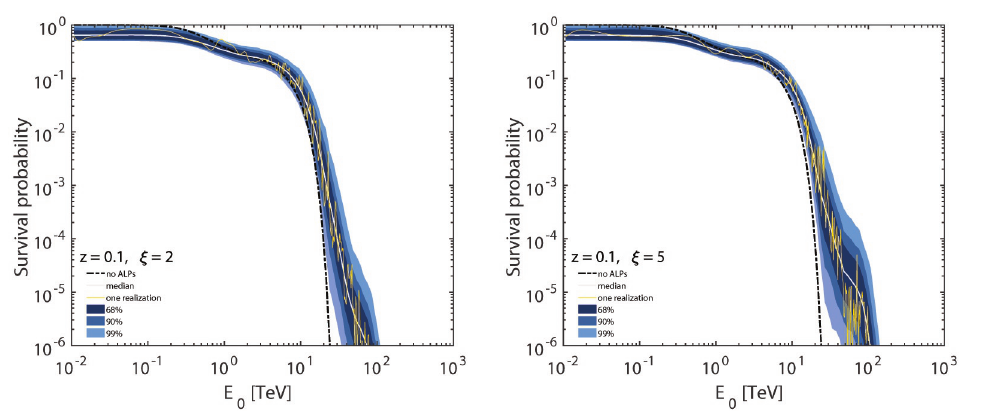
Figure 19. Same as Figure 17 apart from z = 0.1. (Credit [115]). Figures for z = 0.2.